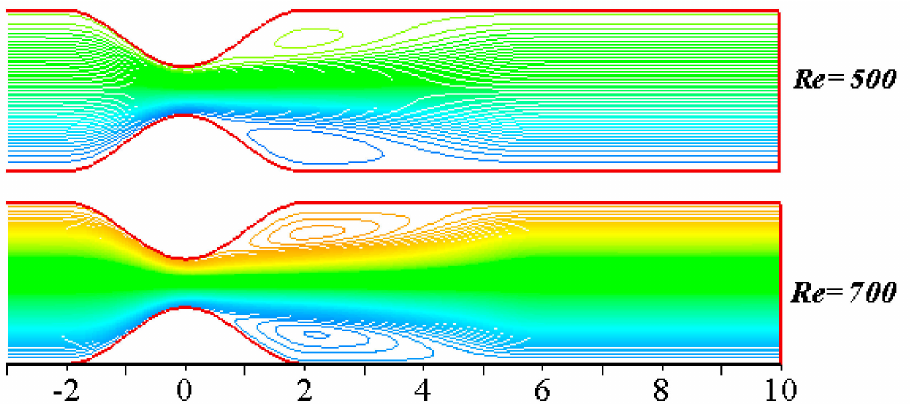
Figure 17. Comparison of the streamlines for Re = 500 and 700 in case of Cu – SWCNT /water, setting M = 5, St = 0.02, Pr = 1, and Rd = 0.2, at t = 0.25.